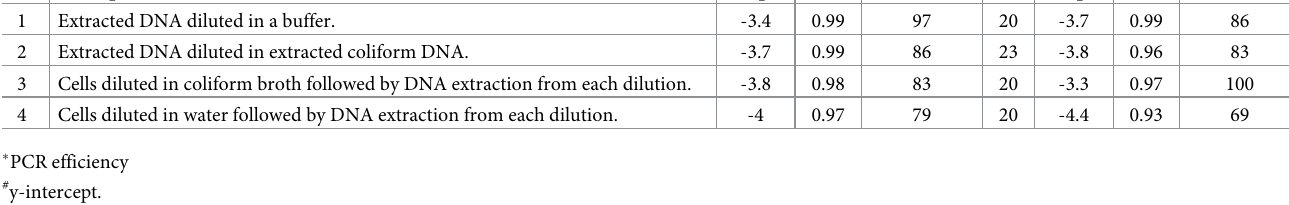
Table 2. Statistical analysis from linear regression between standard curves 1 to 4 for triplicates and 2 repeats, respectively. Standard curve Triplicate q-PCR analysis of each Nr Description Extracted DNA diluted in a buffer. Extracted DNA diluted in extracted coliform DNA. Cells diluted in coliform broth followed by DNA extraction from each dilution. Cells diluted in water followed by DNA extraction from each